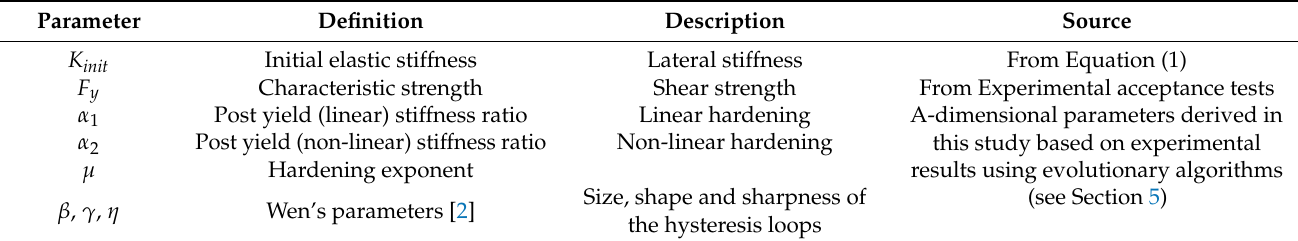
Table 1. Defining parameters of the Elastomeric Bearing (BoucWen)